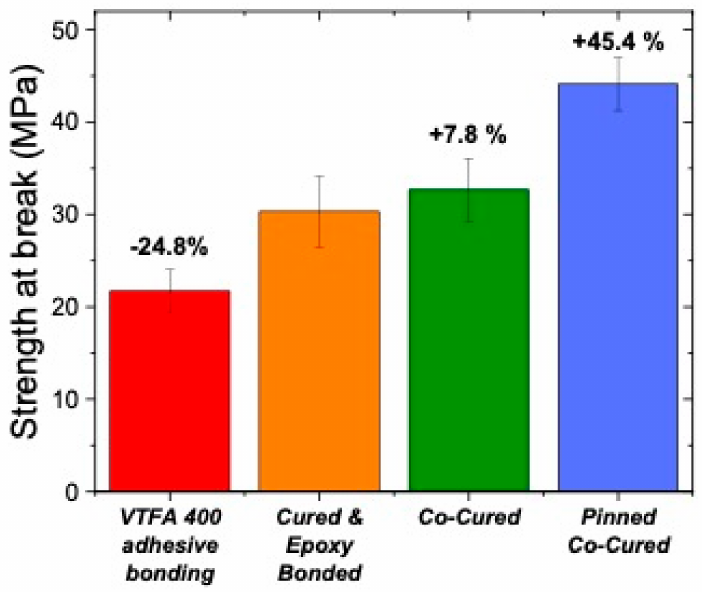
Figure 12. Lap shear strength at break for the four sets of